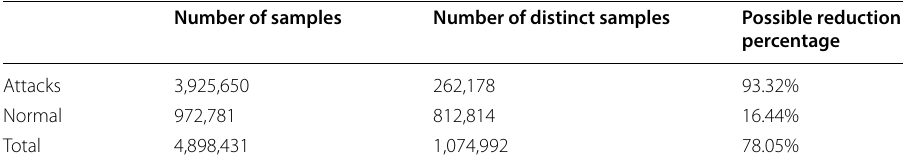
Table 2 Statistics about KDD training set [33]